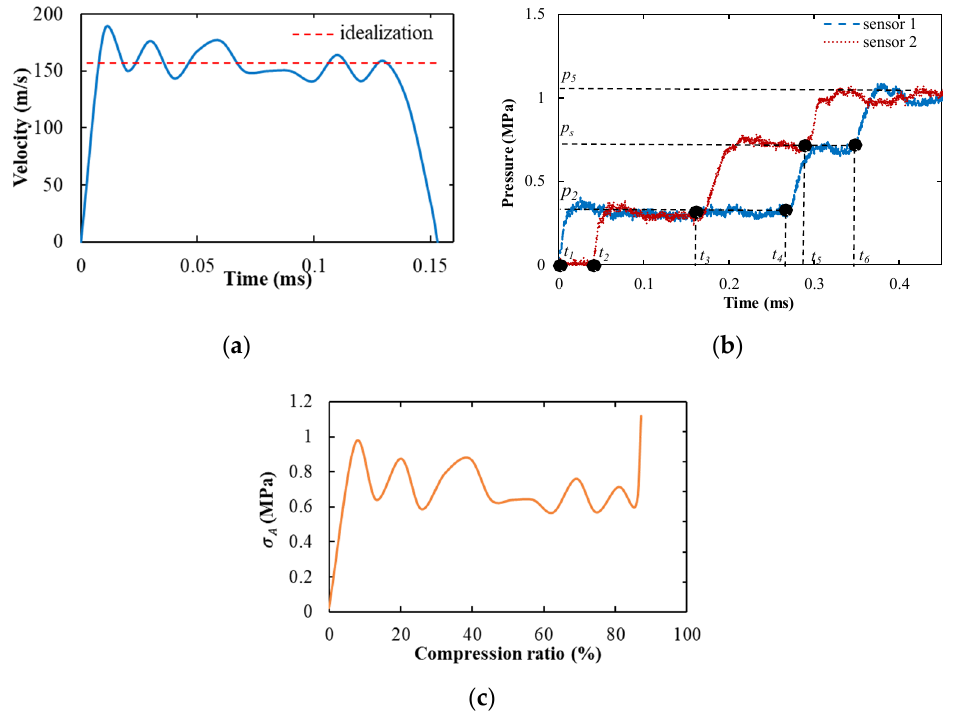
Figure 8. The testing results in the shock tube test: ( a ) the diagram of the velocity of the compression deformation as a function of the time, here, the blue line represents the experiment velocity and the red line represents the idealized velocity, and the average velocity of the compression is about 155 m/s; ( b ) the typical corresponding pressure–time curve of the shock tube, here, the blue line represents the pressure recorded by sensor 1 and the red line represents the pressure recorded by sensor 2, p s represents the first reflected wave, and p 5 represents the second reflection wave; ( c ) the dynamic crushing stress σ A as a function of the specimen compression ratio in the shock tube experiment, which was calculated by Equation (6).